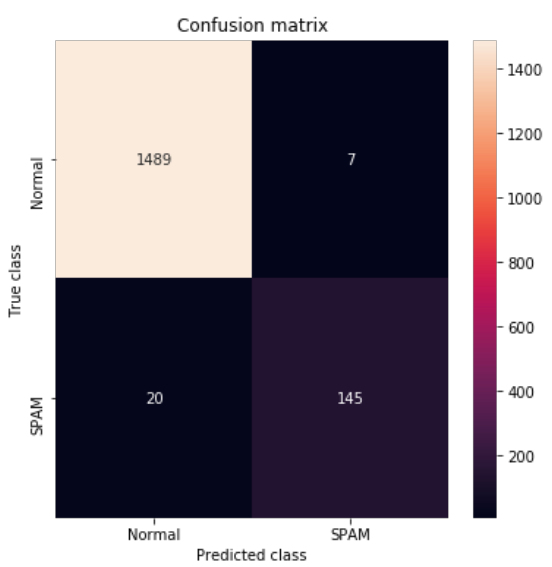
Figure 9. Confusion Matrix of CNN-LSTM model.